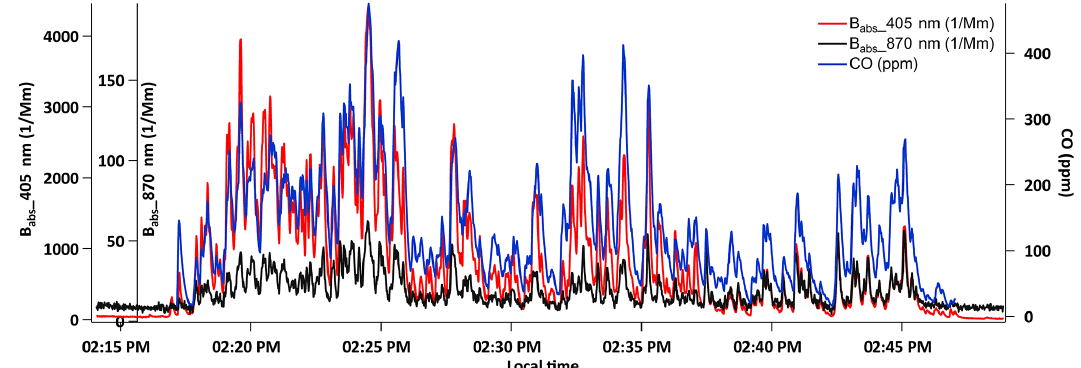
Figure 3. PAX real-time B abs at 870 (black) and 405 (red)nm collected on 5 November showing the dominance of absorbing aerosol at 405nm. The co-located CO mixing ratio measurement from the real-time FTIR data is shown in blue. CO background was obtained from grab samples for increased accuracy. A transition to more glowing dominated combustion with a lower aerosol to CO ratio (and lower AAE and higher MCE, not shown) is observed at about